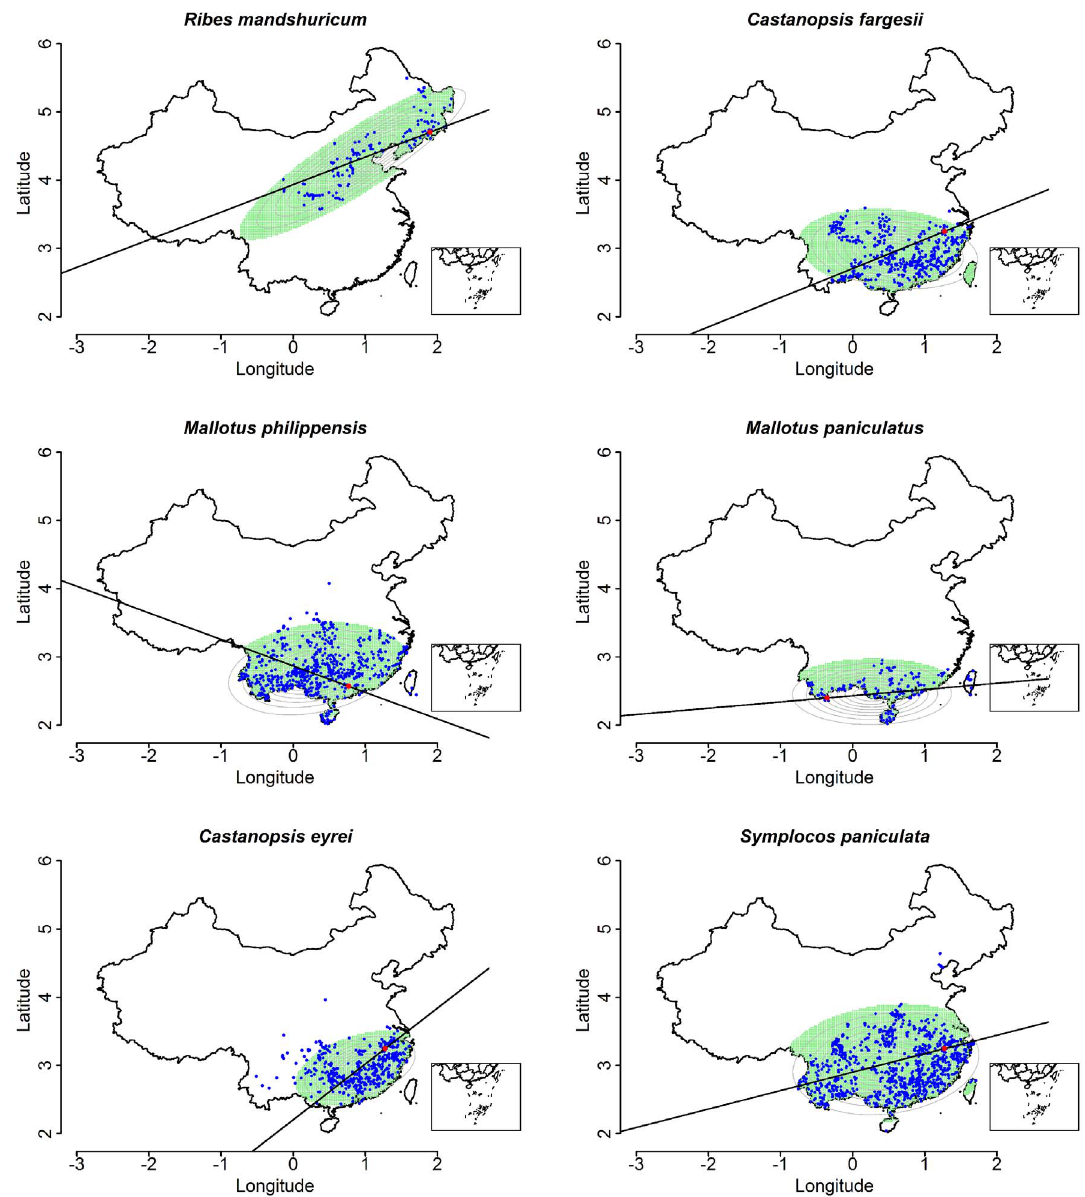
Figure 2. Illustrations of Gaussian distributions estimated with the Bayesian likelihood approach. Red points give locations of the plots in which each species was observed. Straight lines join each plot and the range centers. Ten probability contours evenly spaced from zero to P max, i are shown in gray.